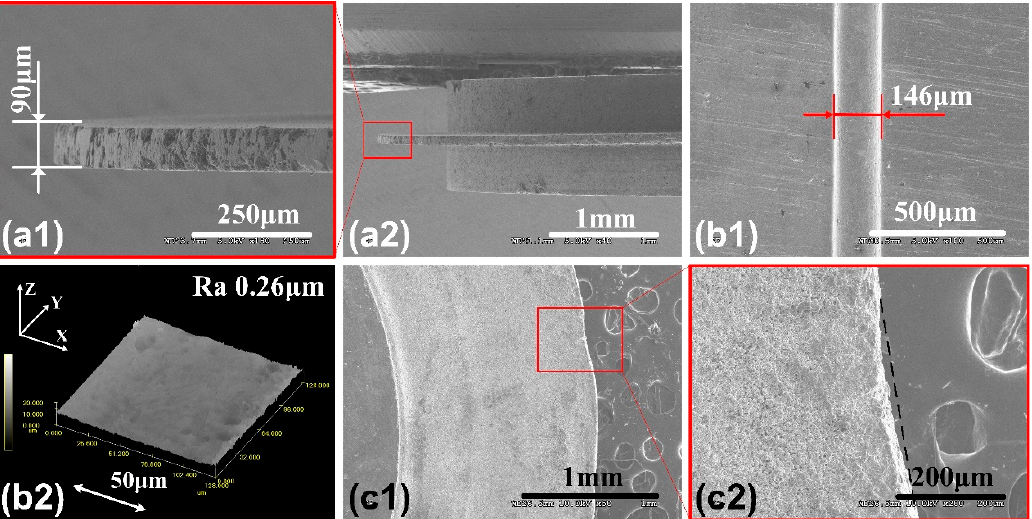
Figure 11. ( a1 , a2 ) SEM images of square-edge graphite disk tool electrode with 90 μ m edge width. ( b1 ) SEM image of the micro-groove using as-prepared 90 μ m width disk electrode under suitable parameters, ( b2 ) 3D morphology of the bottom surface. ( c1 , c2 ) SEM images of used electrode.